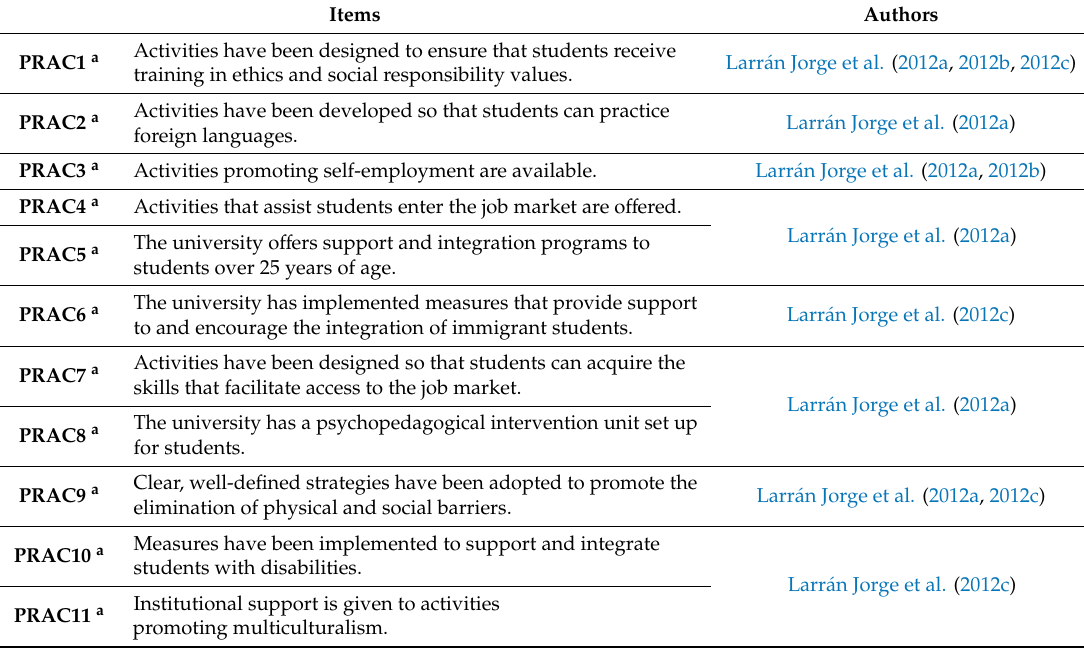
Table 3. Indicators of university practices.